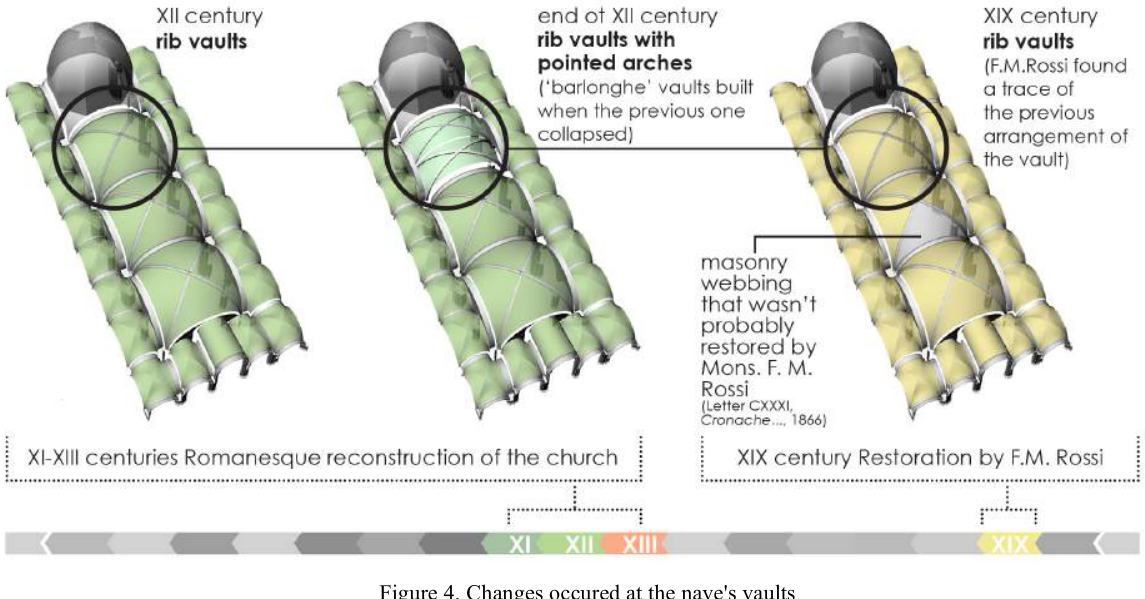
Figure 4. Changes occured at the nave's